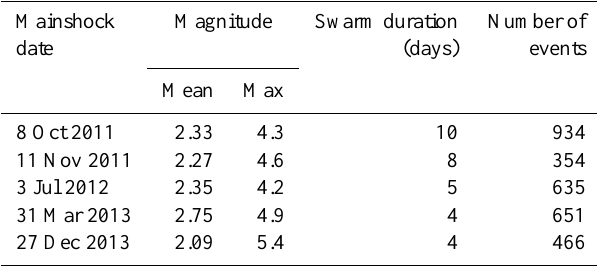
Algorithm 1 Pseudocode of the MRT algorithm developed